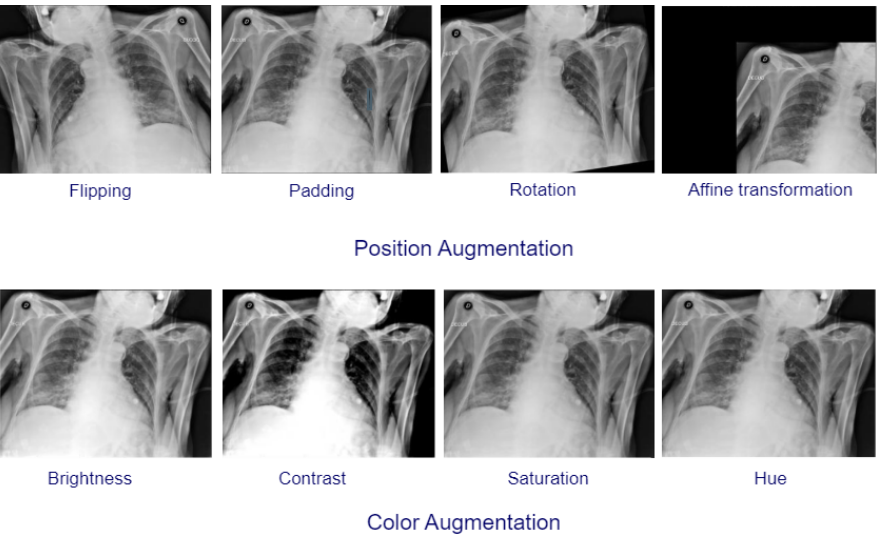
Figure 2. Samples of augmented